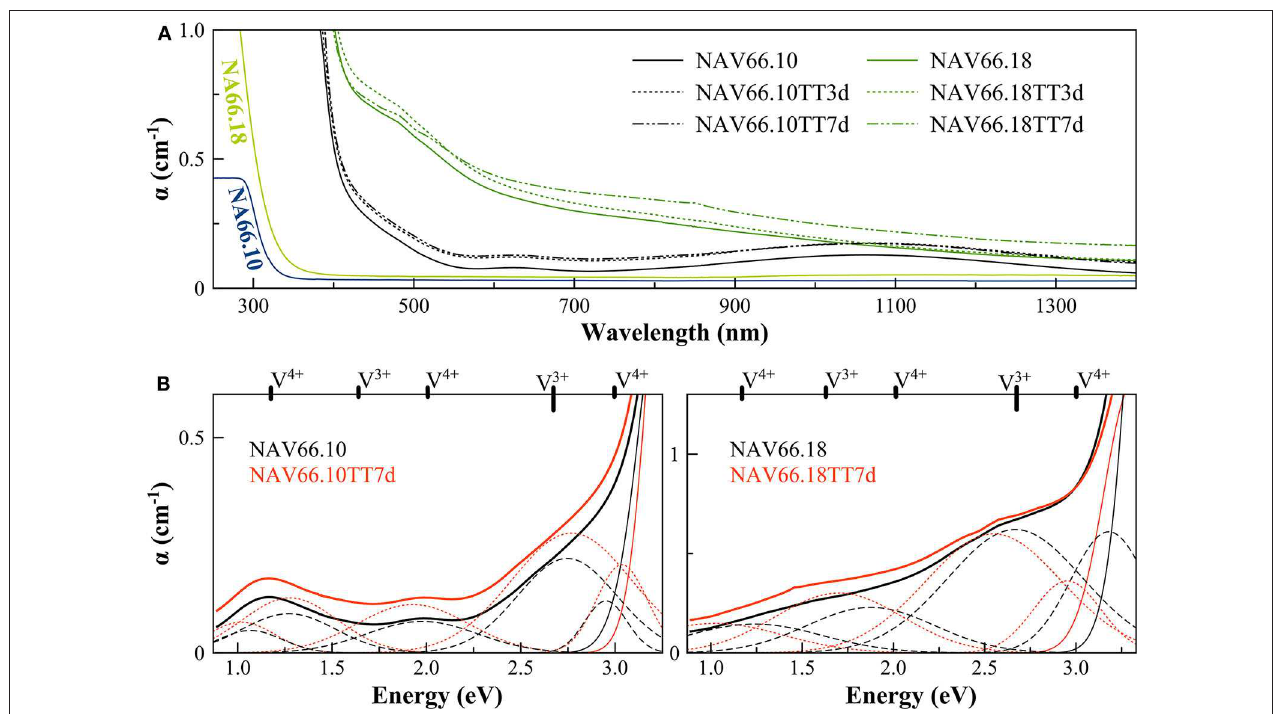
FIGURE 4 | (A) Optical Absorption spectra of pristine and V-doped NAS glasses, melted in air, and thermal treated for 3 (TT3d) and 7 (TT7d) days. (B) Deconvolution of the optical absorption bands for V-doped NAS glasses and 7-day thermally treated ones